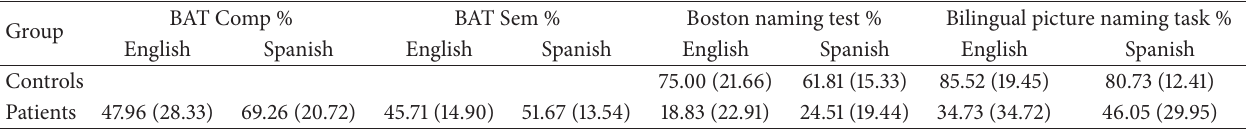
Table 3: Average scores for bilinguals with aphasia and bilingual normal controls on BAT-Comprehension, BAT-Semantics, BNT, and BPNT in English and Spanish. Scores for bilingual normal controls are provided for BNT and BPNT (standard deviations are in